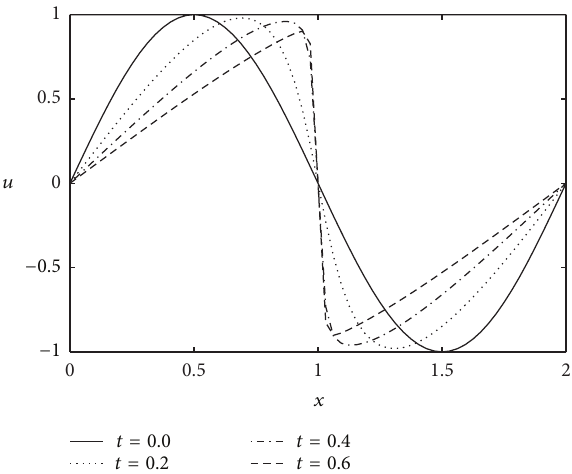
Figure 1: Analytical solutions of the Burgers equation at different